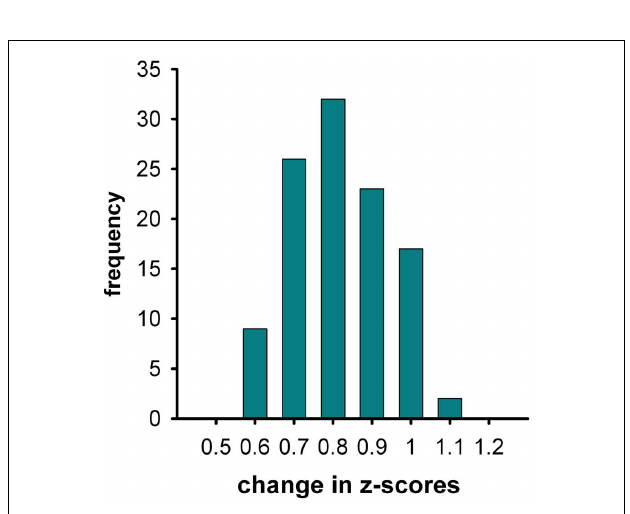
FIGUREA2 | Histogram of the z -scores corresponding to 2mm simulated change in pupil